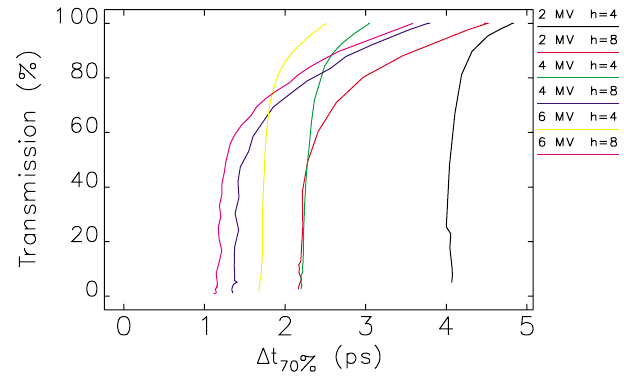
FIG. 24. (Color) Transmission through the slits as a function of the obtained duration of the central 70% of the x-ray pulse, for various deflecting voltages and harmonic numbers of 4 and 8.